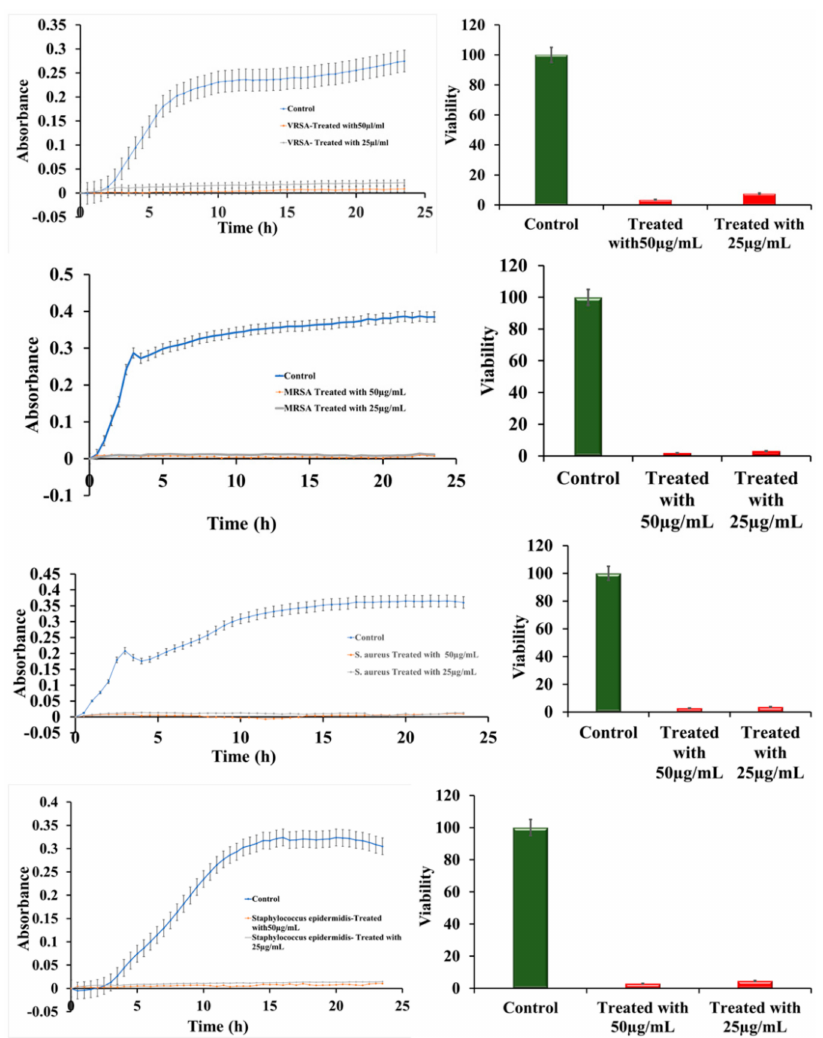
Figure 4. Bacterial growth curve and viability curve ( a – d ); The growth curve of VRSA (CCM 1767), MRSA (ST239: SCCmecIIIA), S. aureus (NCTC 8511), Staphylococcus epidermidis respectively ( e – h ); Viability percentage of VRSA (CCM 1767), MRSA (ST239: SCCmecIIIA), S. aureus (NCTC 8511), hospital sample Staphylococcus epidermidis respectively. Data represent the mean ± SD, n = 3. The cytotoxicity of Ru-S4 was estimated by using normal breast cell line HBL 100 and Cancer Breast cell line MDA MB-468 and prostate epithelial cell line PNT1A. RU-S4 showed negligible toxicity towards the all cell lines (Figure 5, Figure 6, Figure S9). The end conclusion is RU-S4 is completely